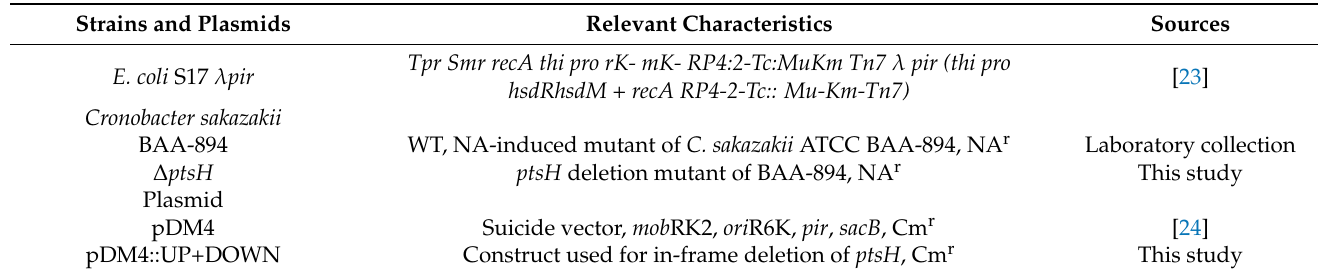
Table 1. Bacterial strains and derivative plasmids that were used in this study. Strains and Plasmids Relevant